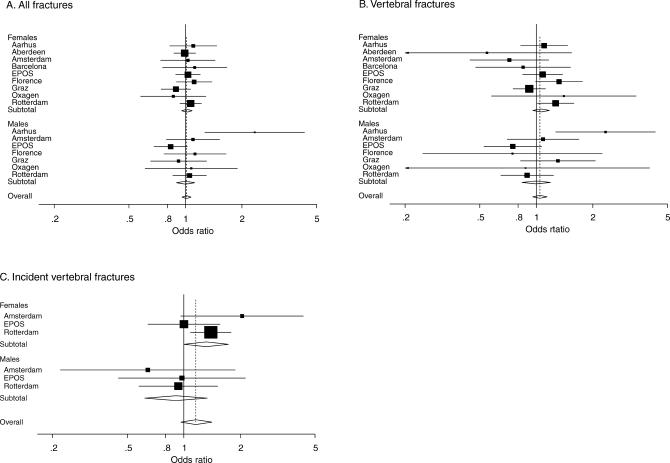
Association between
COLIA1 Alleles and Fractures
OR for fractures in co-dominant models (per T allele) for (A) fracture at any site; (B) vertebral fracture; and (C) incident vertebral fracture. Point estimates and 95% CIs are shown for the ORs in each study. Summary estimates of the ORs and their 95% CIs (diamonds) are given by random effects models per gender and for the total database.